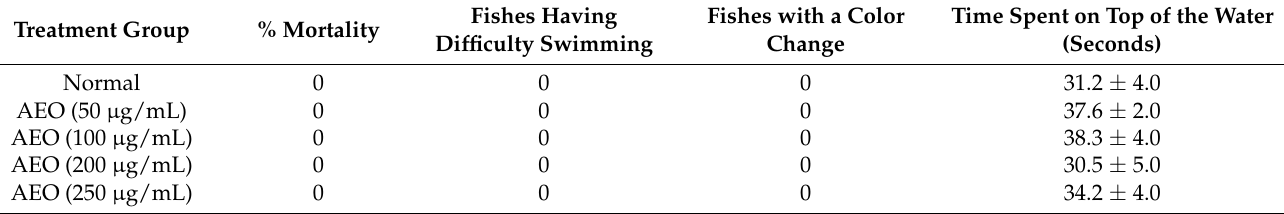
Table 5. Toxicity analysis of Allspice essential oil (AEO) against a non-targeted organism (guppy fishes) at different doses. Treatment